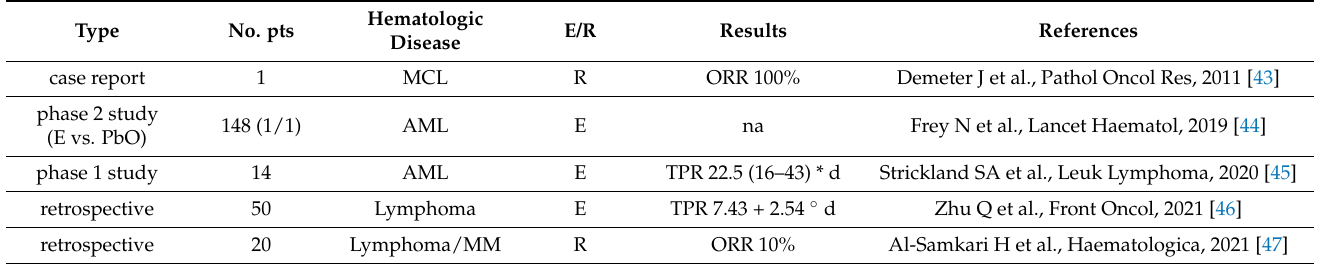
Table 2. Studies on TPO-RA after chemotherapy.